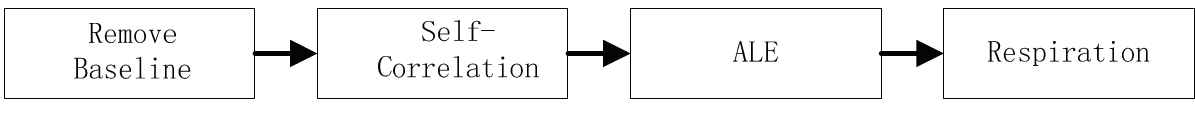
Figure 2. Signal processing block